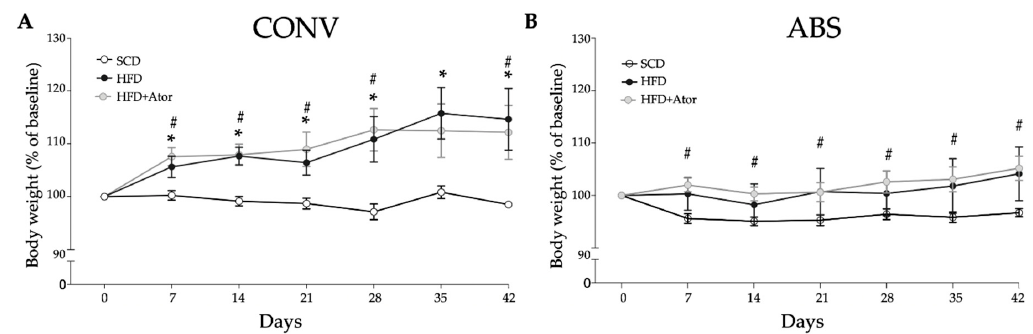
Figure 2. Course of body weight gain in CONV ( A ) ( n = 15) and ABS ( B ) ( n = 20) mice in response to SCD or HFD. Error bars indicate SEM.* = p <0.05 SCD vs. HFD, # = p < 0.05 SCD vs. HFD+Ator.